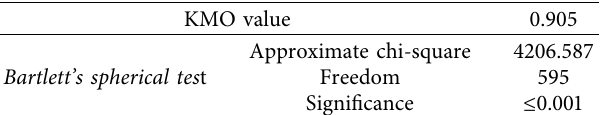
Table 4: KMO test and Bartlett’s